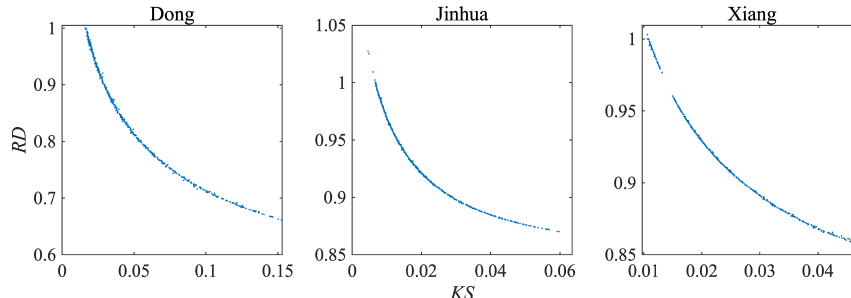
Figure 10. Relationship between KS and RD in the three cases.